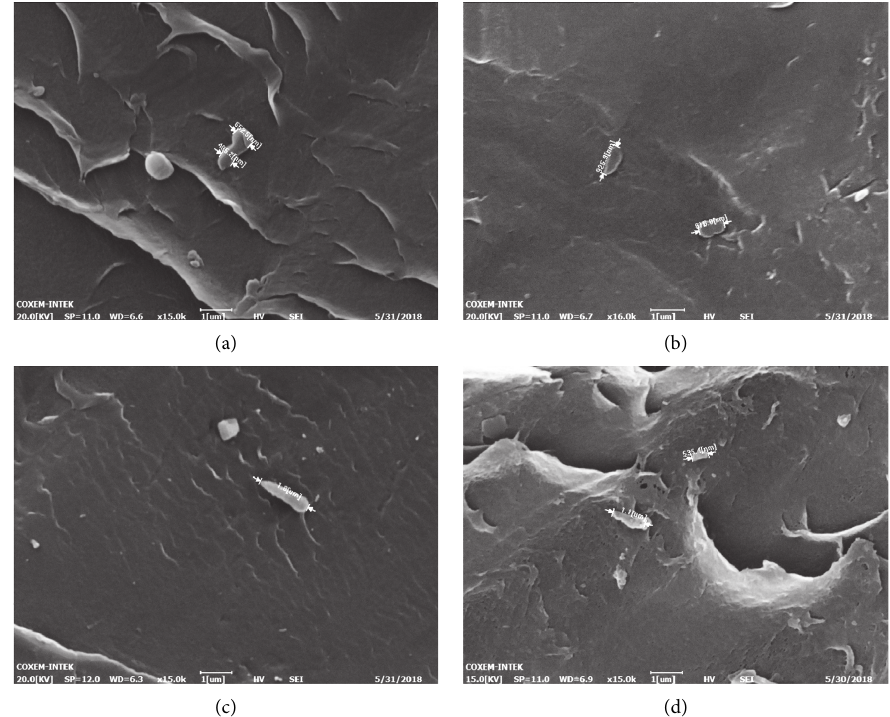
Figure 12: Effect of AgNPs in S. braenderup morphology as assessed by SEM. In the presence of AgNPs, a concentration ratio of 1 :2 for 3hr